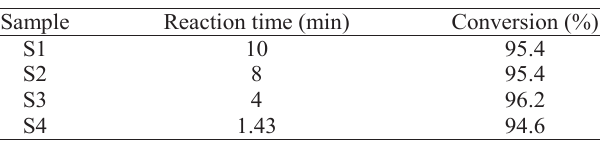
The conversion data for samples prepared at different reaction time.